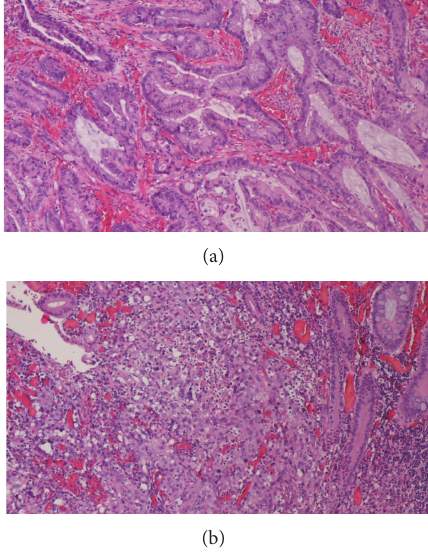
Figure 5: (a) Colon hepatic flexure tumor biopsy. Moderately differentiated adenocarcinoma of the colon hepatic flexure (hema- toxylinandeosinstaining, × 100).(b)Ascendingcolontumorbiopsy. Undifferentiated carcinoma of the ascending colon (hematoxylin and eosin staining, ×